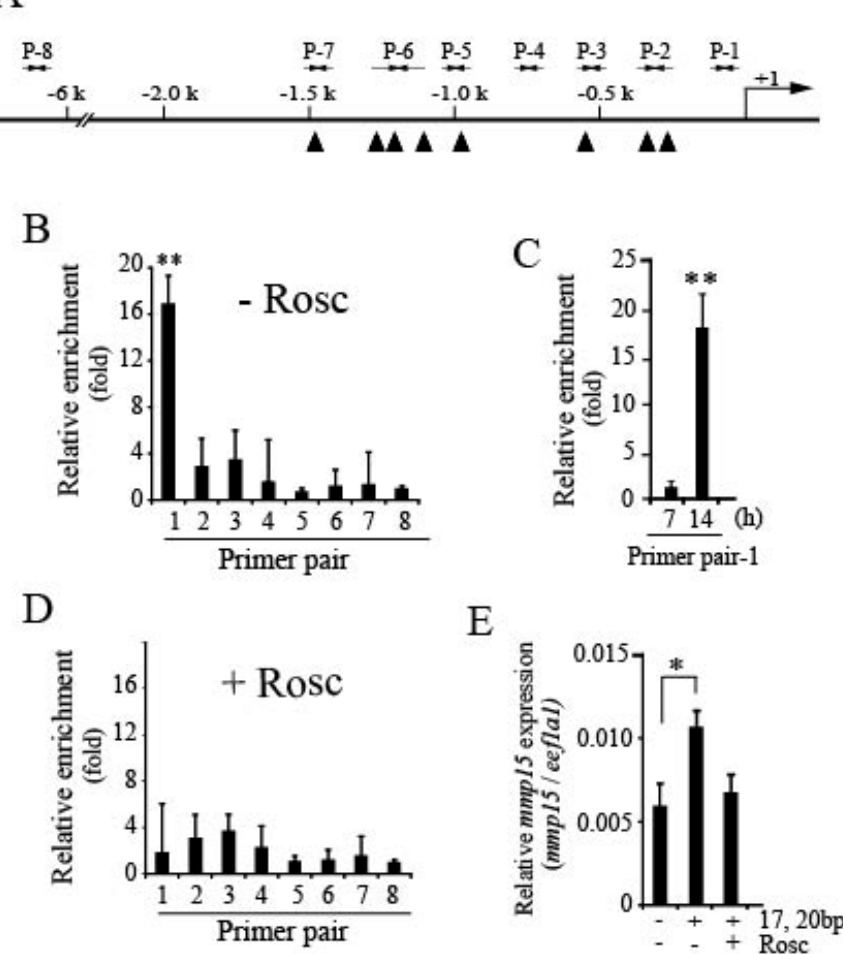
Figure 4. Effect of roscovitine treatment of follicles on Pgr binding to the mmp15 promoter region. ( A ) For ChIP assays to examine the binding of Pgr to mmp15 promoter region, seven ChIP primer pairs (P1–P7) in the 1.5 kb upstream region of the transcription start site (indicated as +1) of the